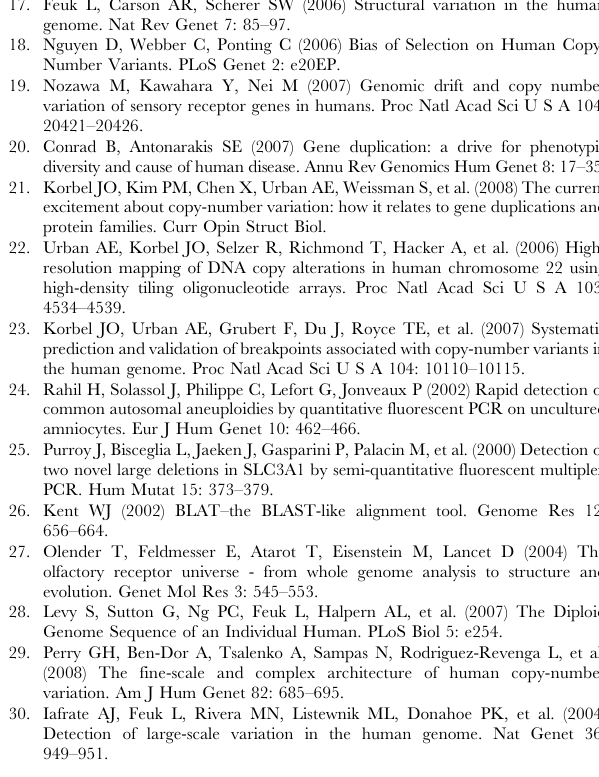
OR loci with R . 0.18 were called as gains, and with R , 0.18 as losses, respectively, relative to the designated reference individual NA19154. Table S3 *Evidence for both a gain and a loss observed in a single territory and sample. **This CNV likely corresponds to a deletion with breakpoint junctions fusing OR51A2 and OR51A4, previously seen by us using another method (Korbel et al. 2007, Science 318:420-6). This deletion results in a new gene with a coding region identical to OR51A4 and upstream regions from OR51A2, which is combined with a loss of the OR51A2 coding region. ***Breakpoints within a locus were called if, and only if, at least 5 probes were on either side of the breakpoint junction, supporting the predicted dosage change. ****For eight loci (OR2T11, OR4S1, OR4N2, OR11H3P, OR10H2, OR7E125P, OR7E96P, and OR13J1) at least two breakpoints intersecting with the locus were predicted with a distance of more than 1000 bp apart from each other. This suggests that in those loci CNVs may have been formed recurrently, as the expected resolution of the calls is , 500 bp (see Methods). Found at: doi:10.1371/journal.pgen.1000249.s013 (0.04 MB XLS) Text S1 Supplementary